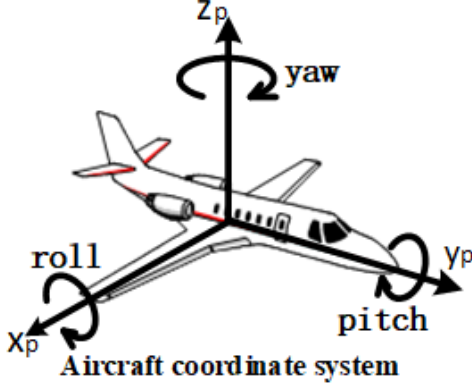
Figure 1. Definition of aircraft attitude angle.